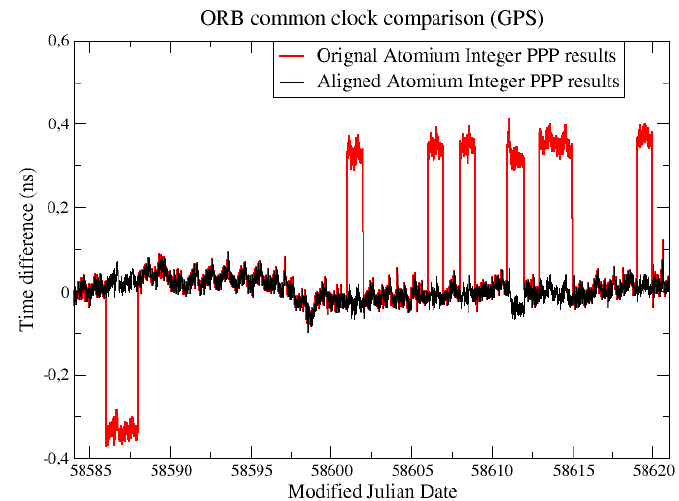
Figure 15. CCD experiments at ORB with integer PPP.